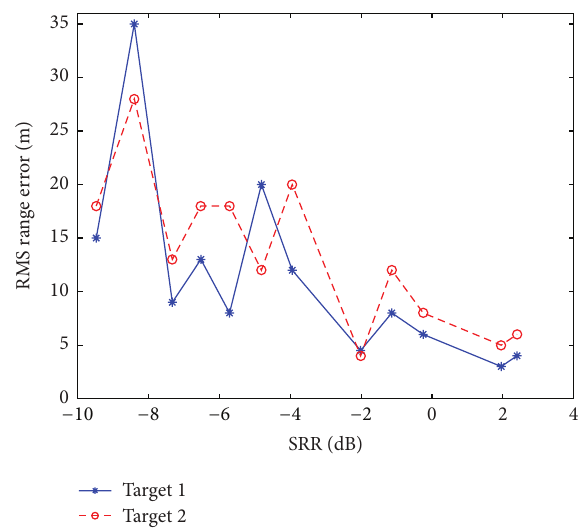
Figure 10: The RMS range errors of two targets over different SRR values and SNR is equal to −